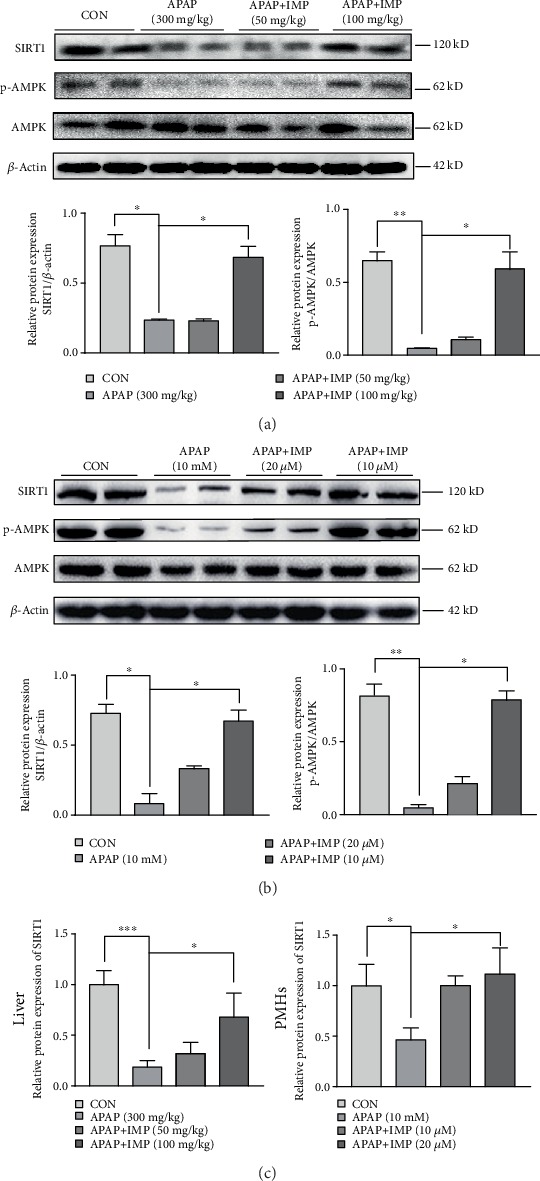
Pretreatment with IMP alleviates APAP overdose-induced oxidative damage with activation of SIRT1 and promotion of the phosphorylation of AMPK. (a, b) The protein expression of SIRT1 and p-AMPK in WT mouse liver tissue and PMHs was analyzed by Western blot. Quantitative analysis of scanning densitometry of protein bands for SIRT1, p-AMPK, and AMPK. (c) The relative expression of SIRT1 in WT liver tissue and WT PMHs was determined by qRT-PCR. IMP: imperatorin; APAP: acetaminophen; SIRT1: Sirtuin 1; AMPK: adenosine 5′-monophosphate- (AMP-) activated protein kinase; p-AMPK: phosphorylation of adenosine 5′-monophosphate- (AMP-) activated protein kinase; PMHs: primary mouse hepatocytes. Results are expressed as fold changes compared to the vehicle-treated control group. ∗p < 0.05; ∗∗p < 0.01; ∗∗∗p < 0.001.